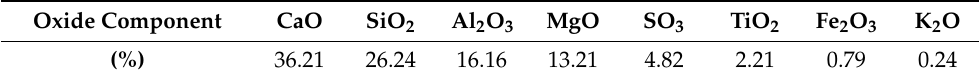
Table 2. Main oxide components of S95 slag.